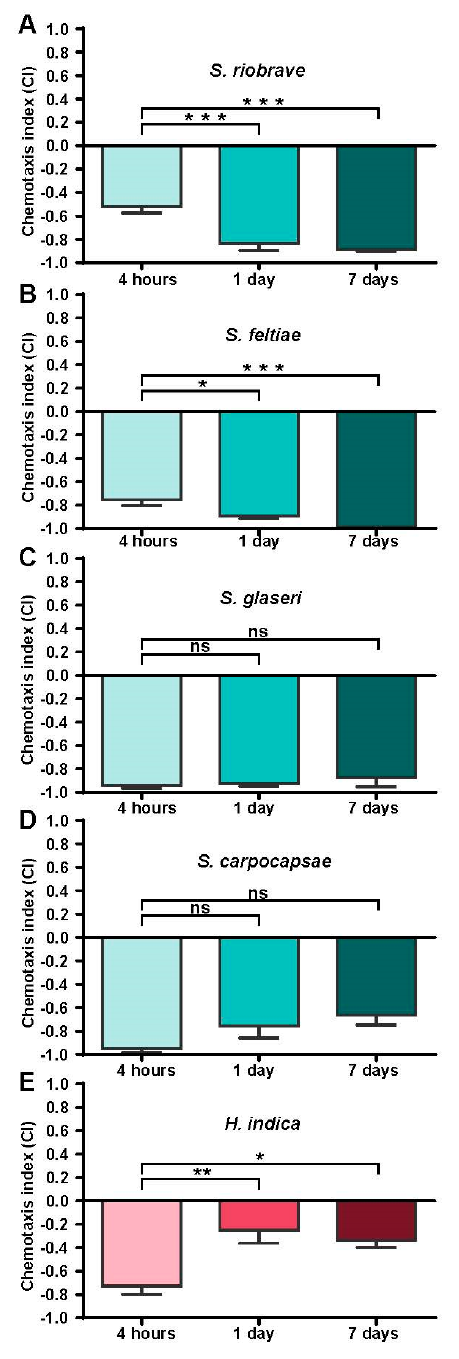
Figure 2. Chemotaxis index results for IJs at several times post collection (in response to 200 mM prenol). For chemotaxis index (CI) values: a score near − 1 indicates high repulsion, near 0 indicates neutrality, and + 1 indicates strong attraction. Statistical comparisons for chemotaxis indices were carried out using ordinary one-way ANOVA, stars indicate the results of the Tukey multiple comparisons test, indicating if the time post-collection had an effect on the response of EPN to prenol as a distal-chemotactic cue. Mean is shown and error bars represent SEM. * p < 0.05; ** p < 0.01; *** p < 0.001.